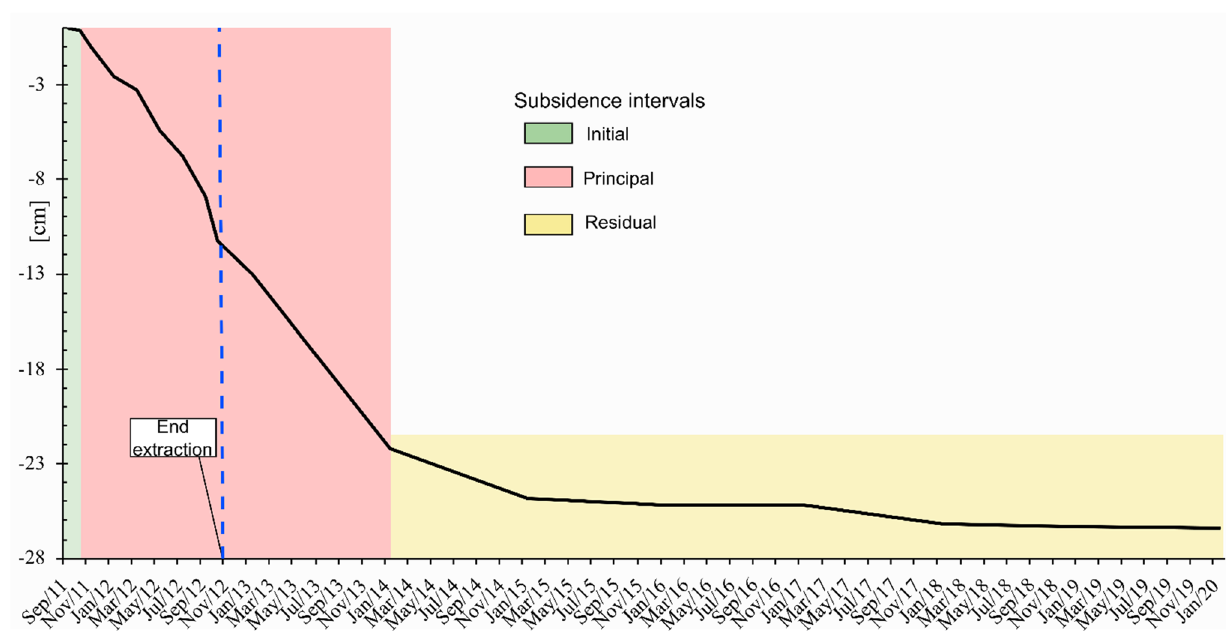
Fig. 11 Profile of maximum vertical cumulated displacement compared to three subsidence phases: initial (green), principal (red), residual (yel-